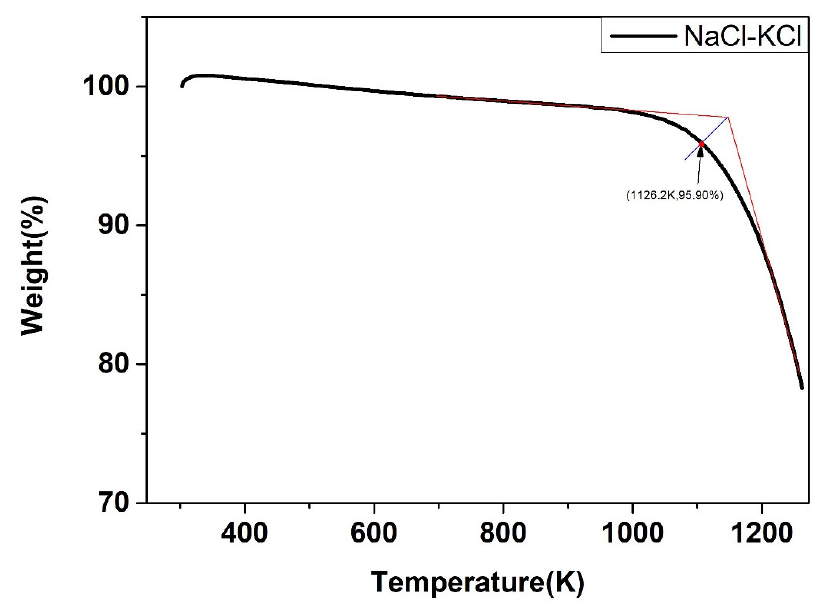
Table 10. Calculated and experimental value of the upper ‐ temperature limit of the binary chloride salts.